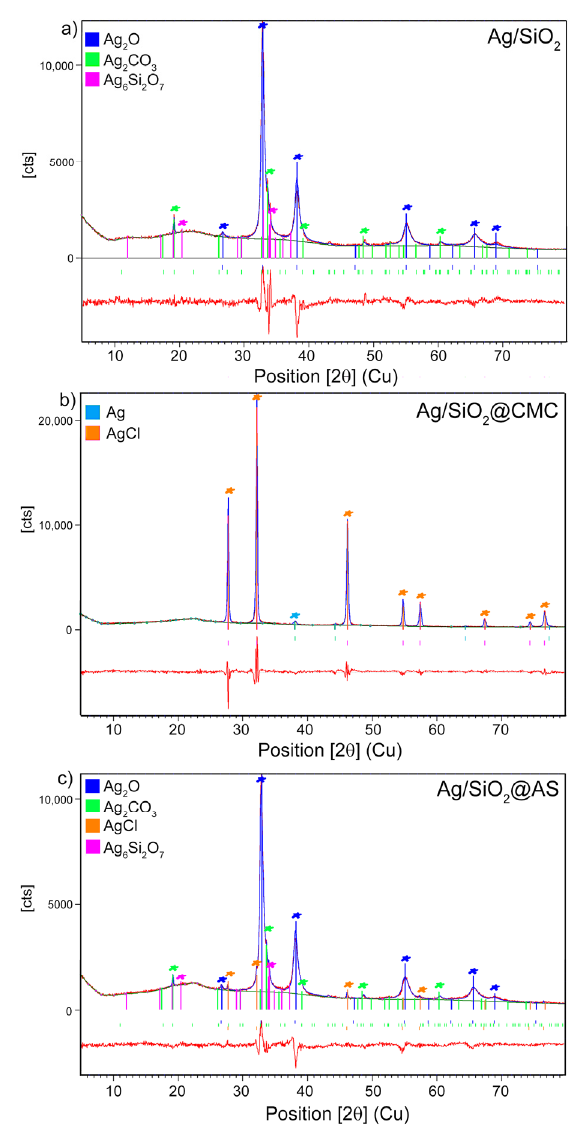
Figure2. XRDpatternof( a )initialAg / SiO 2 powderandmodifiedsystemsby( b )carboxymethylcellulose: Figure 2. XRD pattern of ( a ) initial Ag/SiO 2 powder and modified systems by ( b ) Ag / SiO 2 @CMC and ( c ) sodium alginate: Ag / SiO 2 @AS with the Rietveld refinement (red carboxymethylcellulose: Ag/SiO 2 @CMC and ( c ) sodium alginate: Ag/SiO 2 @AS with the Rietveld refinement (red line). Table 1. The lattice parameters were determined from the XRD data and the analysis of the Rietveld refinement.